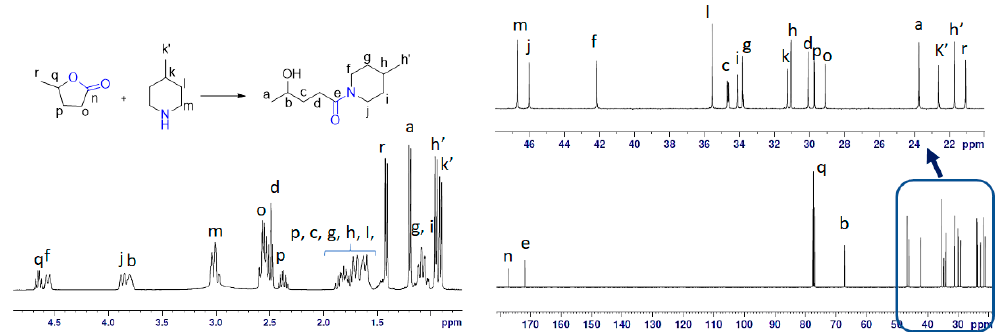
Figure 5. NMR study of equimolar solution of GVL and PIP under MW at 90 °C for 1 h. Left part explains the 1 H-NMR whereas the bottom right side of the figure shows the 13 C-NMR with an expansion of the 10–50 ppm region in the top right corner.